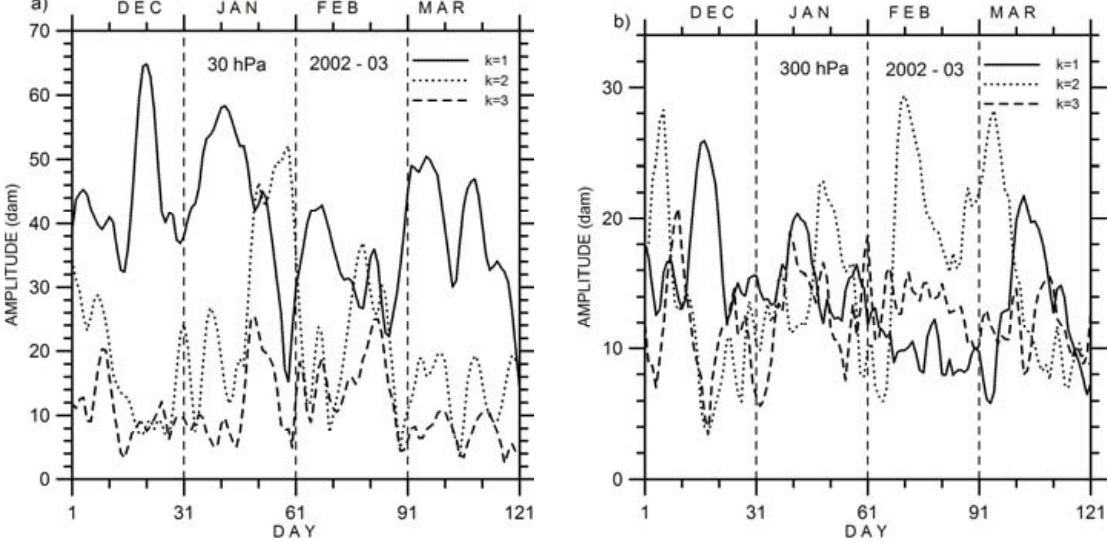
Fig. 6. Amplitude of planetary waves with zonal wave numbers k = { 1 , 2 , 3 } in geopotential height (dam) at 30hPa (a) and at 300hPa (b) averaged over the latitudinal belt 40 ◦ –75 ◦ N from 1 December 2002 until 31 March 2003 (a,